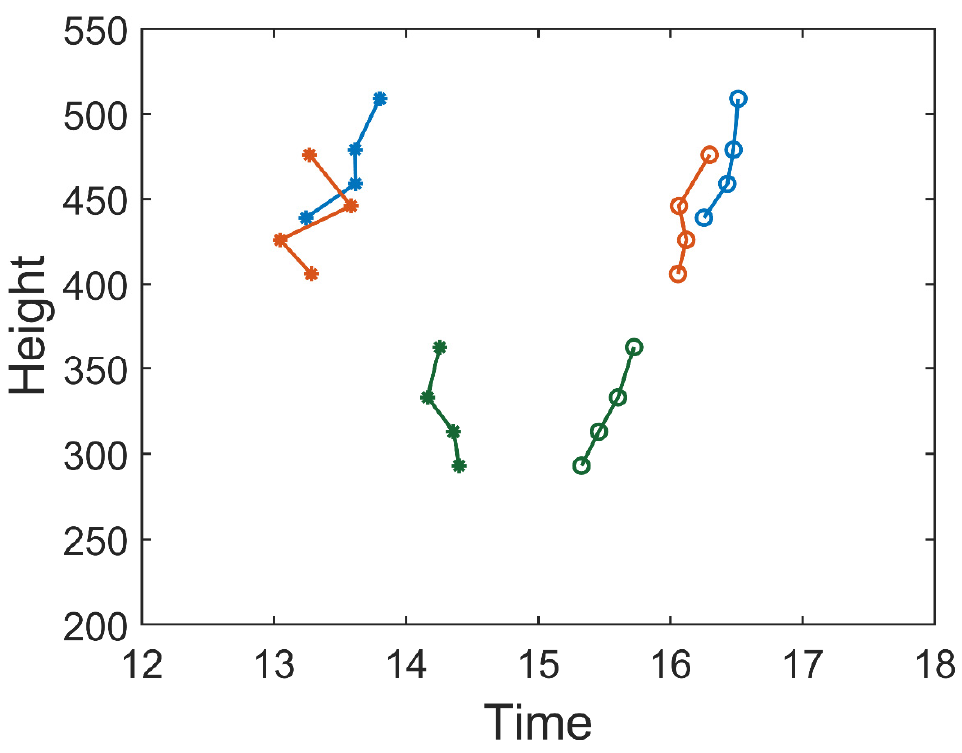
Figure 6. The time of extreme values of wind speed (stars) and wind direction (circles). Blue: Tower 1; Orange: Tower 2; Green: Tower 3 .